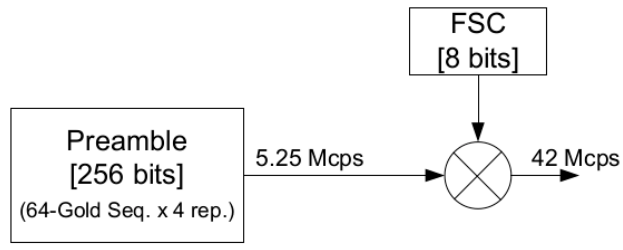
Figure 6. Preamble generation block diagram.